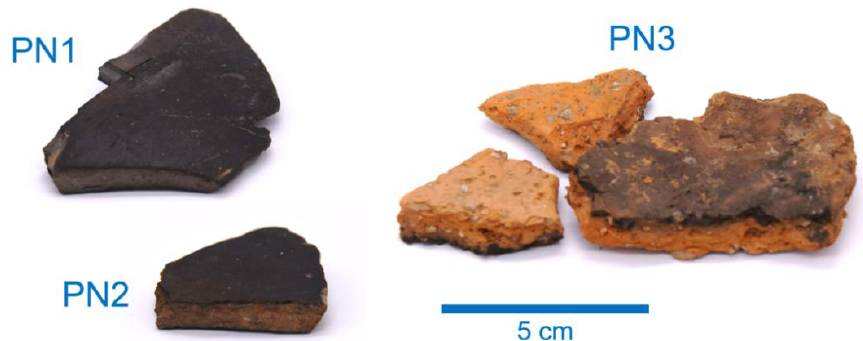
Figure 1. Pottery shard samples unearthed from the Pungnaptoseong site [36].